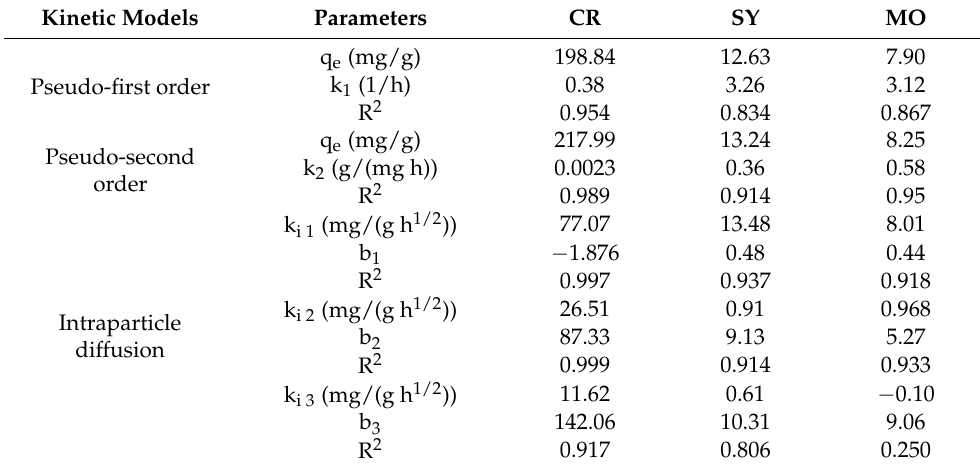
Table 2. Kinetic parameters for adsorption of three dyes onto the PDA/PEI-TPU